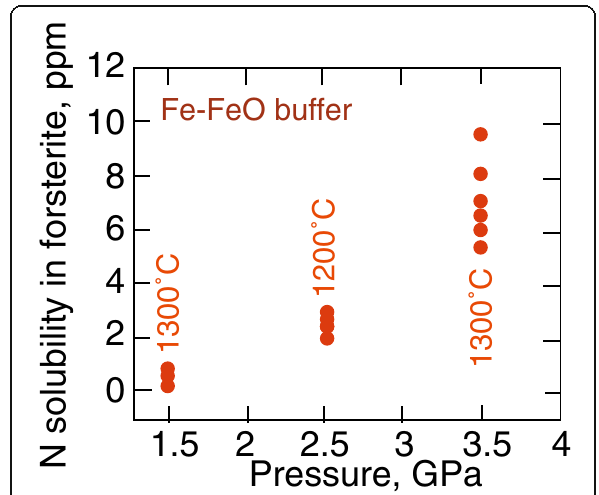
Fig. 6 Summary of nitrogen solubility of forsterite at different oxygen fugacities indicated and fixed temperature and pressure (modified from Li et al. 2013)